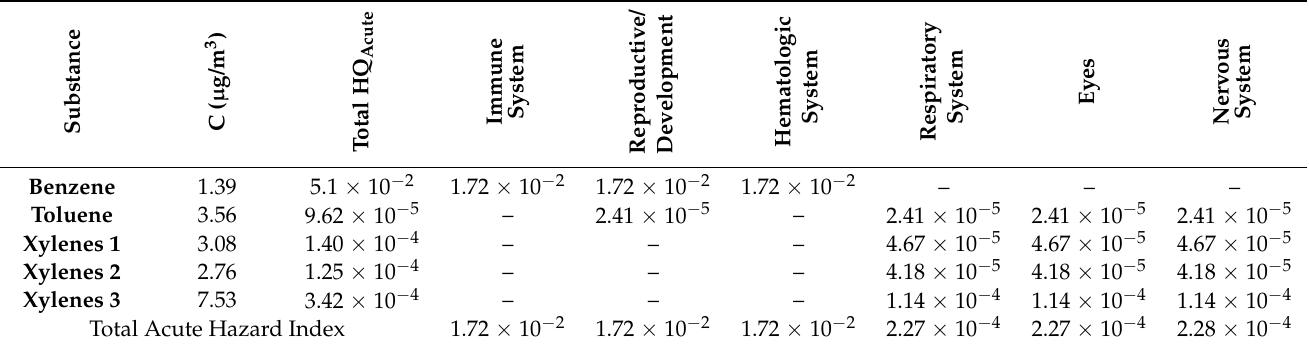
Table A6. HQ for each Target organ System(s) & Acute HI. B.I method (OEHHA,